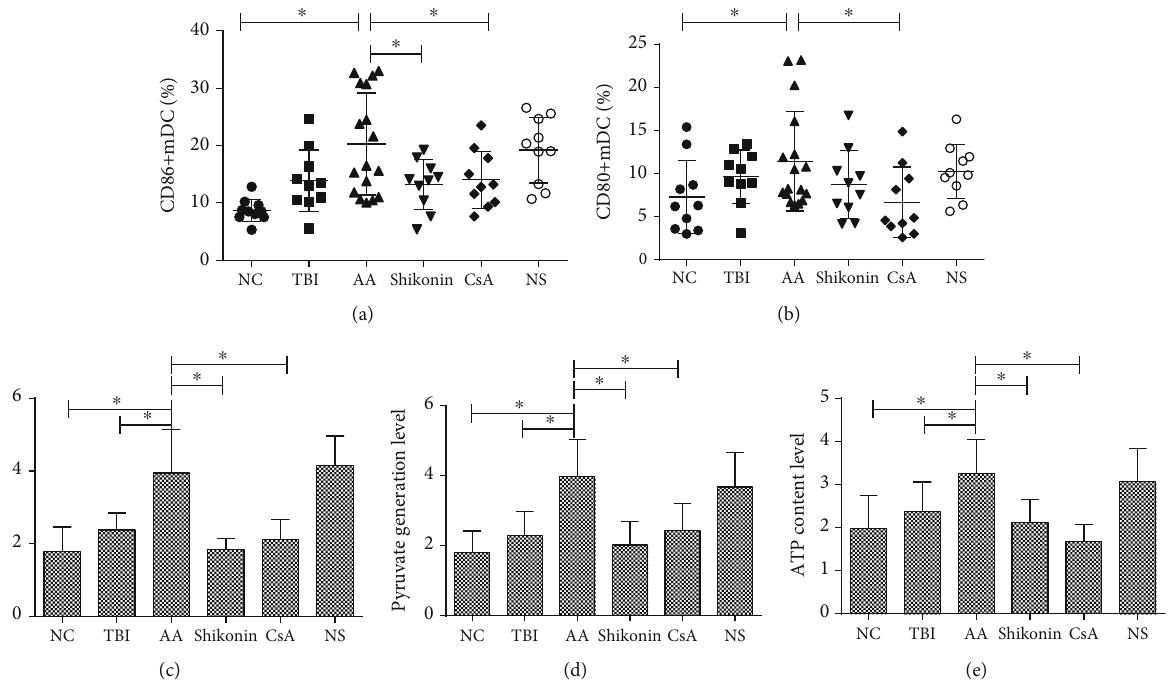
Figure 3: (a) The CD86+ mDCs in the AA group signi fi cantly increased compared with those of the NC and TBI groups ( p < 0 : 05 ). After the treatments, the CD86 levels in the shikonin and CsA groups decreased signi fi cantly compared with that in the AA group ( p < 0 : 05 ). (b) The CD80+ mDCs in the AA group signi fi cantly increased compared with those in the NC group ( p < 0 : 05 ). The CD80 levels in the CsA group decreased compared with those in the AA group ( p < 0 : 05 ). (c) The glucose consumption levels in mDCs of the AA group were signi fi cantly higher than those in the TBI and NC groups, while those in the shikonin and CsA groups were signi fi cantly lower than those in the AA group ( p < 0 : 05 ). (d) The pyruvate levels in mDCs of the AA group were signi fi cantly higher than those in the TBI and NC groups, while those in the shikonin and CsA groups were signi fi cantly lower than those in the AA group ( p < 0 : 05 ). (e) The ATP contents in mDCs in the AA group were signi fi cantly higher than those in the TBI and NC groups, while those in the shikonin and CsA groups were signi fi cantly lower than those in the AA group ( p < 0 : 05 ). AA: aplastic anemia ( n = 17 ); TBI: total body irradiation ( n = 10 ); NC: normal control ( n = 10 ); shikonin ( n = 10 ); CsA: cyclosporin A ( n = 10 ); NS: normal saline ( n = 10 ) ( ∗ p < 0 : 05